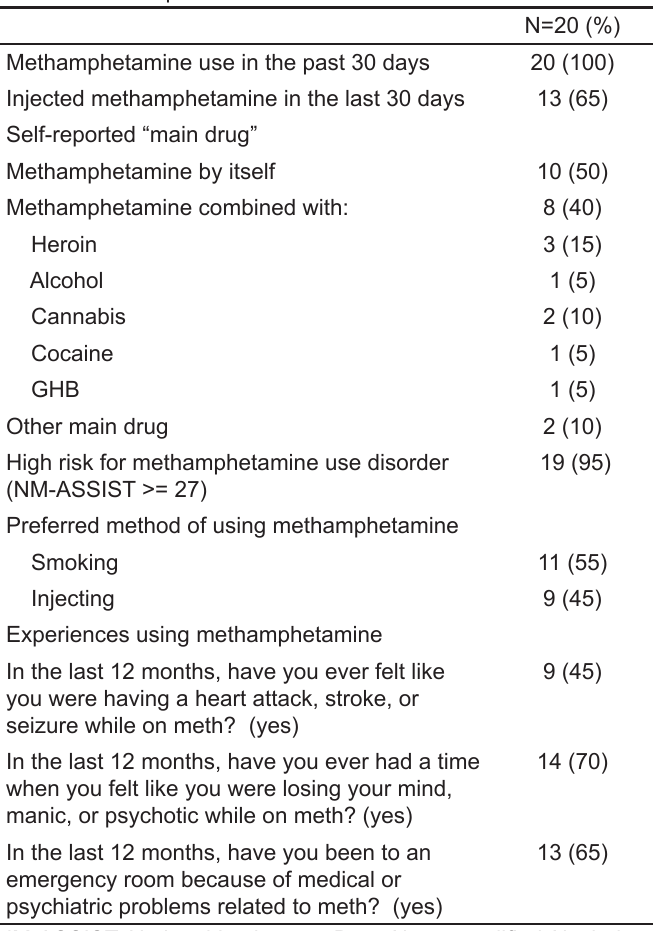
Table 2. Methamphetamine use characteristics of